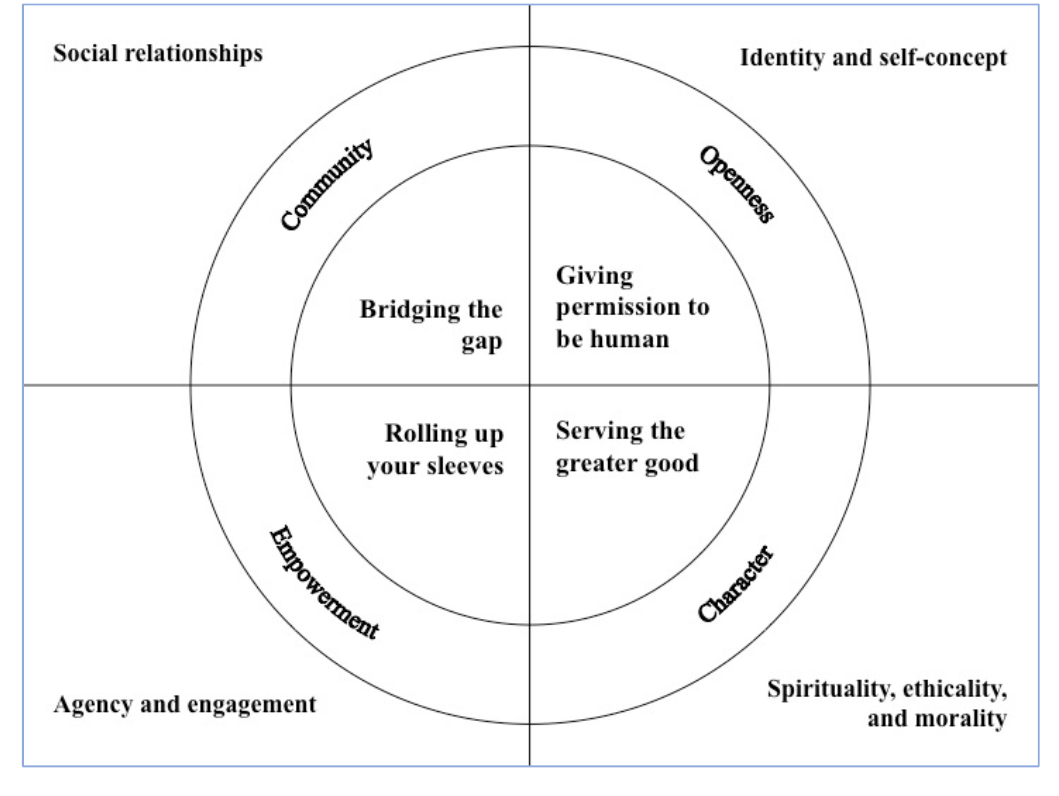
Figure 1. Camp-Based Model of Youth Leadership